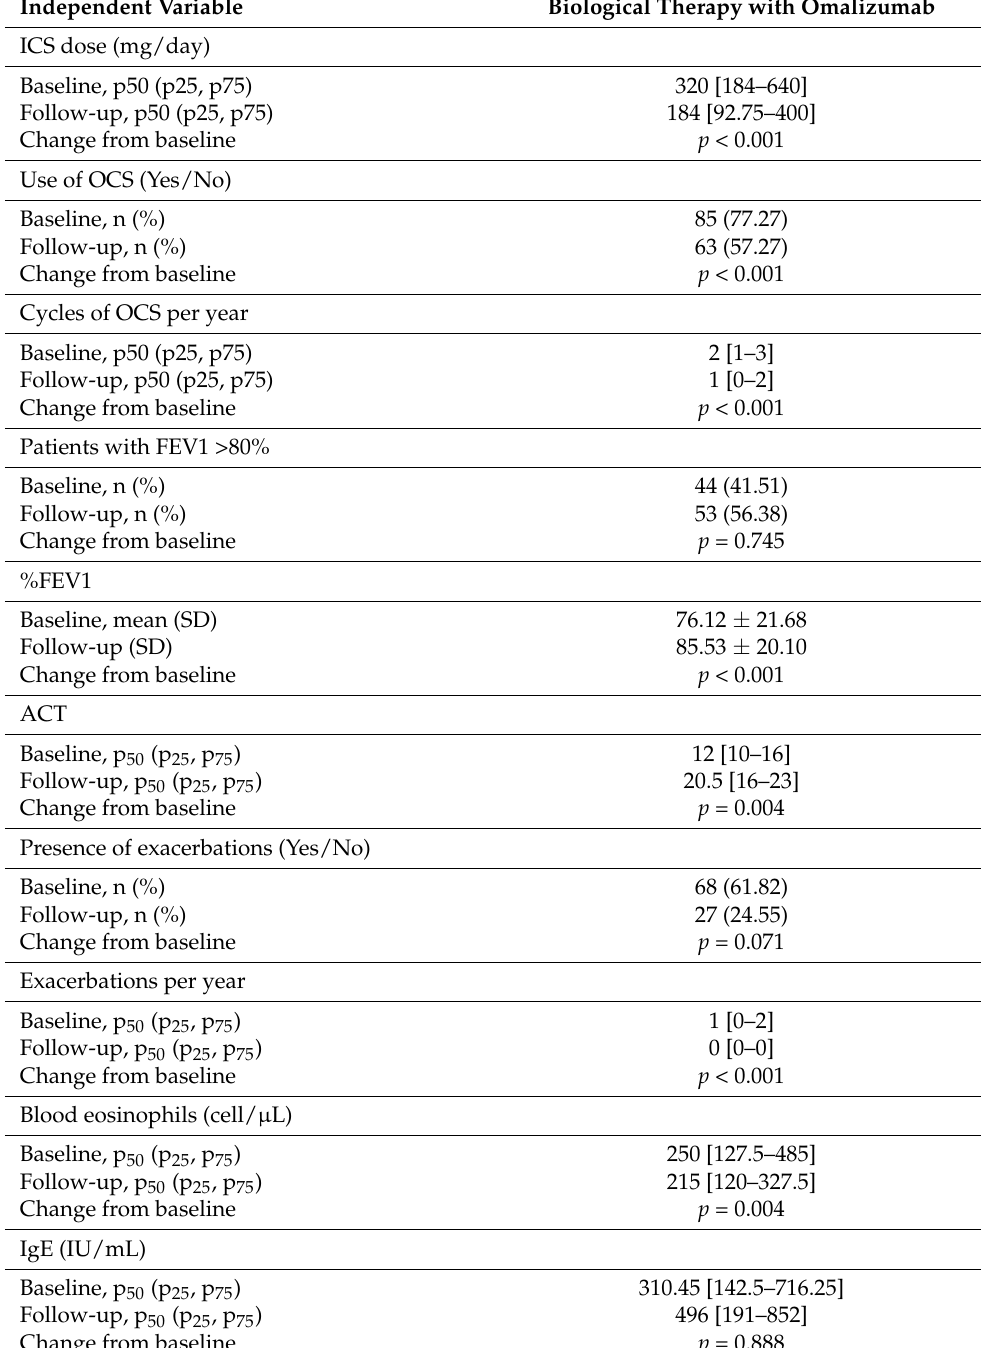
Table 3. Changes in the baseline variables after 12 months of biological